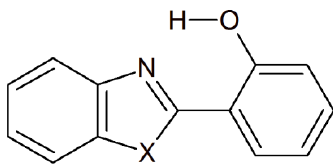
Figure 1. Enolic form for 2- (2’ -hydroxyphenyl)benzoxazole (HBO) (X = O), 2- (2’ -